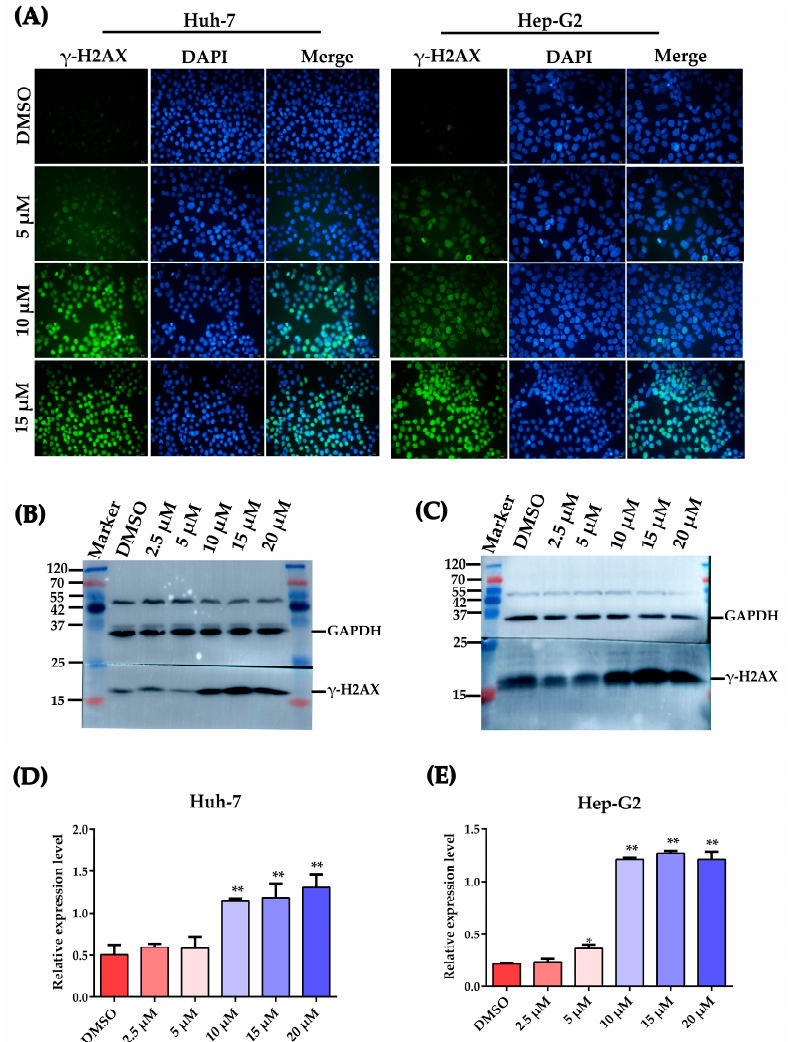
Figure 4. Plumbagin-induced DNA damage in HCC Cells. ( A ) Examples of pictures captured by fluorescent microscopy. The DNA damage marker γ -H2AX expression was revealed by green fluorescent signal, and the cellular nucleus is represented as blue fluorescence. Scale bar = 20 µ m. ( B , C ) Western blot analysis of the expression levels of γ -H2AX after PLB treatment for 12 h. ( D , E ) Gray value statistical analysis of the relative expression levels of γ -H2AX after plumbagin treatment at different concentrations. * p < 0.05, ** p < 0.01 compared to the DMSO group; the data are